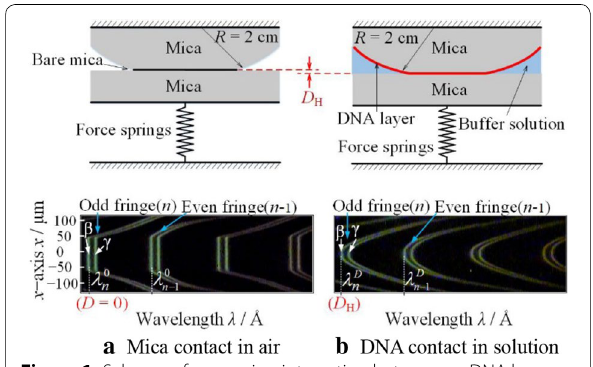
Figure 1 Scheme of measuring interaction between ss‑DNA layer and a bare mica with the SFA